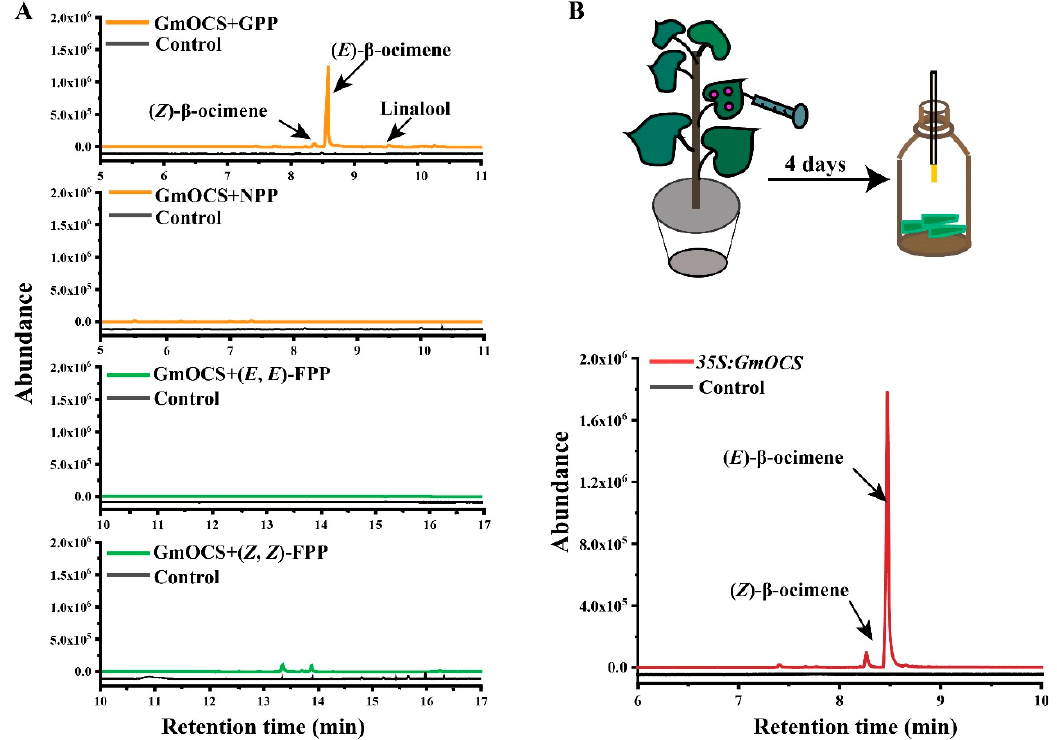
Figure 4. In vitro and in vivo characterization of GmOCS. ( A ) In vitro enzymatic analysis of GmOCS using four acyclic prenyl diphosphate substrates. X-axis represented retention time, and the y-axis represented product abundance. The contents of enzymatic products were detailed in Supplementary Table S2. ( B ) Volatile terpenes released from N. benthamiana leaves transiently overexpressing GmOCS . Agrobacterium containing GmOCS in pEAQ-HT backbone was in fi ltrated into N. benthamiana leaves. The leaves were sampled and analyzed by SPME-GC/MS analysis. N. benthamiana leaves in fi ltrated by Agrobacterium containing empty pEAQ-HT were used as control.